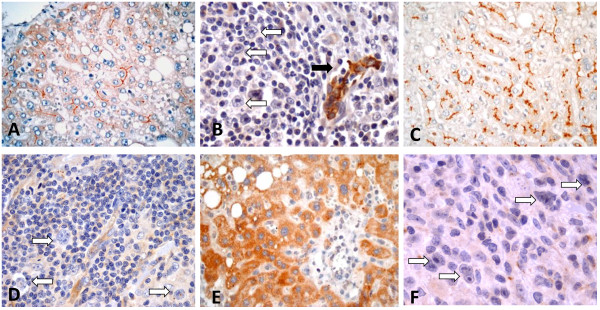
Immunohistochemical expression of ABC proteins in positive controls and call tumors. A. Canalicular staining pattern of MDR1 in liver (positive control). B. MDR1 is not expressed in the HRS cells of CHL (white arrows); endothelial cells are positive (black arrow). C. Canalicular staining pattern of ABCC2 in liver (positive control). D. HRS cells are negative for ABCC2; endothelial cells and scattered lymphocytes are positive. E. Hepatocytes show cytoplasmic expression of ABCC3 (positive control). F. HRS cells are negative for ABCC3.